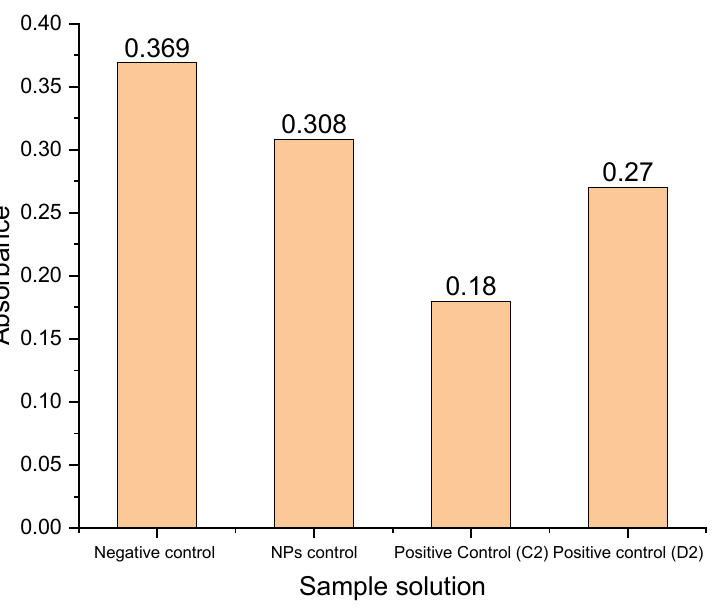
Figure 10. Absorbance rate of E. coli strain.